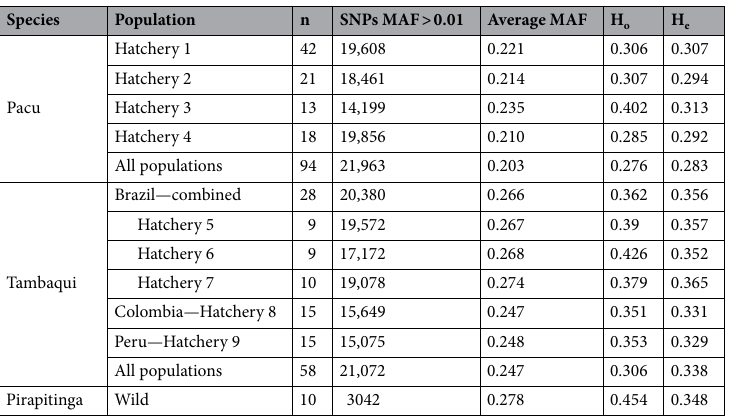
Table 4. Descriptive population genetic estimates for the sampled pacu and tambaqui populations included in the validation of the array.